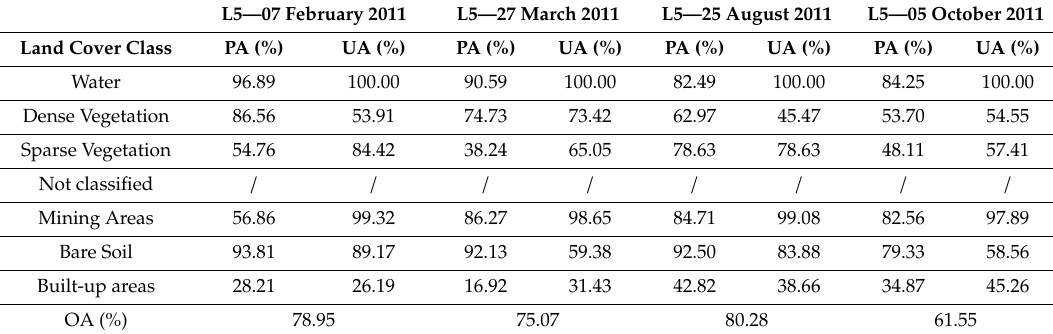
Table 11. OA, PA, and UA obtained through the application of Normalized Di ff erence Bareness Index (version 2) (NDBIaI2) on the data acquired by Landsat 5 mission. UA, user’s accuracy; PA, producer’s accuracy; OA, overall accuracy.